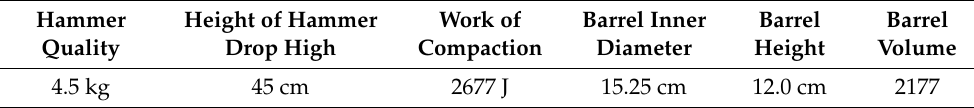
Figure 1. Multi-functional electric compaction instrument for repeated compaction tests. Table 1. Main characteristics of the compaction instrument.